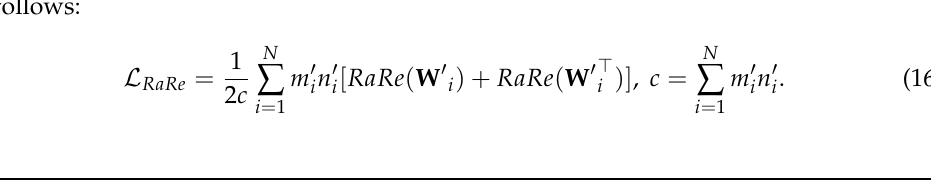
Algorithm 1: Training a neural network with Dynamic Low-Rank